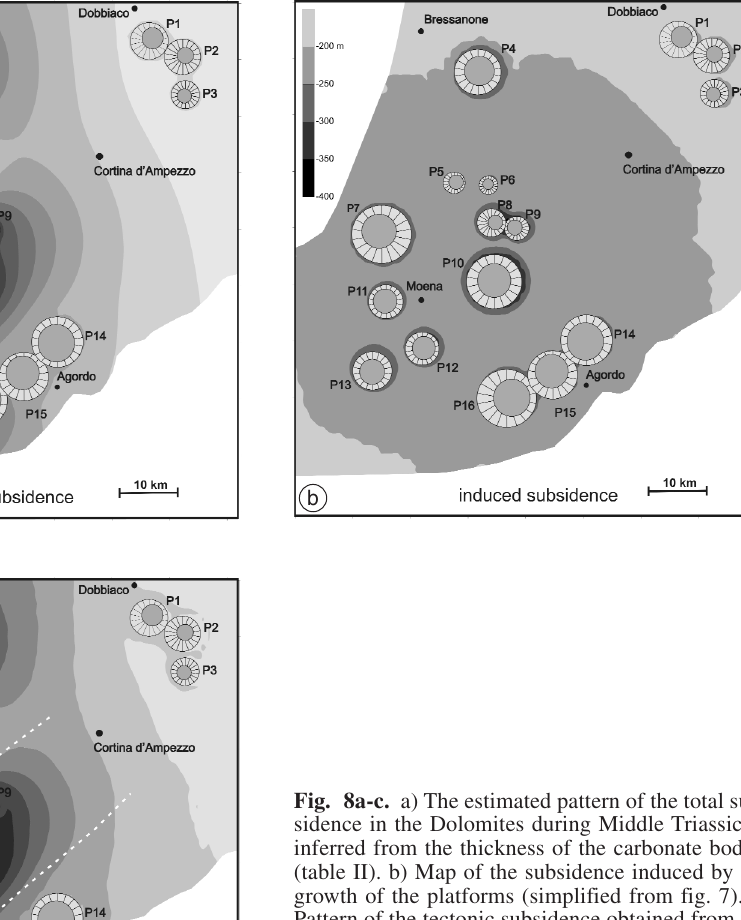
Fig. 8a-c. a) The estimated pattern of the total sub- sidence in the Dolomites during Middle Triassic as inferred from the thickness of the carbonate bodies (table II). b) Map of the subsidence induced by the growth of the platforms (simplified from fig. 7). c) Pattern of the tectonic subsidence obtained from the former two maps and likely induced by a far field extensional stress field. The map emphasises the ex- istence of a NE-SW oriented graben affecting the Central Dolomites. Dashed lines represent the two major border faults (or fault systems). Contours lines are in metres in all three maps (see correspon- ding grey